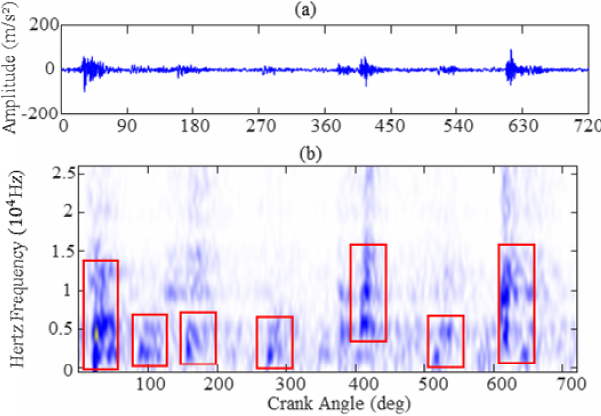
Figure 5. Vibration signal of SFI: ( a ) original signal waveform; ( b ) STFT.